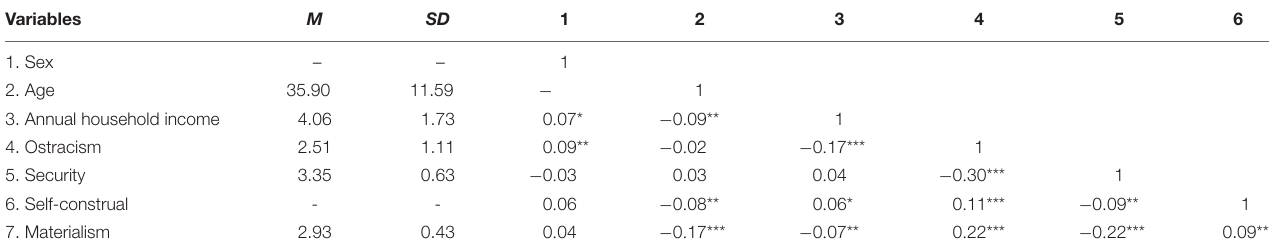
TABLE 1 | Descriptive statistics and correlations among all variables.